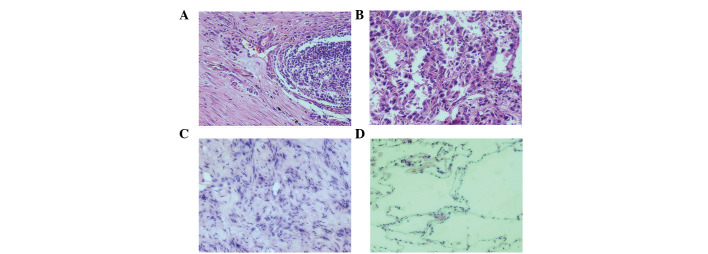
Hematoxylin and eosin (H&E) staining of subtypes of cancerous tissue and their corresponding non-tumor tissue (×200). (A) Lung squamous cell carcinoma: Cancer cells are polygonal with a greater amount of cytoplasm, deep nuclear staining and intercellular bridges. Keratin pearls are shown. (B) Lung adenocarcinoma: Glandular structures are visible in the cancer tissue and cancer cells are comparatively large with abundant cytoplasm and large nuclei containing secretory granules or mucocysts. (C) Small cell lung cancer: Cancer cell morphology is similar to the oat grain with relative consistency in size, a large nucleus and deep staining. (D) Non-tumor tissue: The structure is similar to that of normal lung tissue and certain specimens exhibit inflammatory cell infiltration.